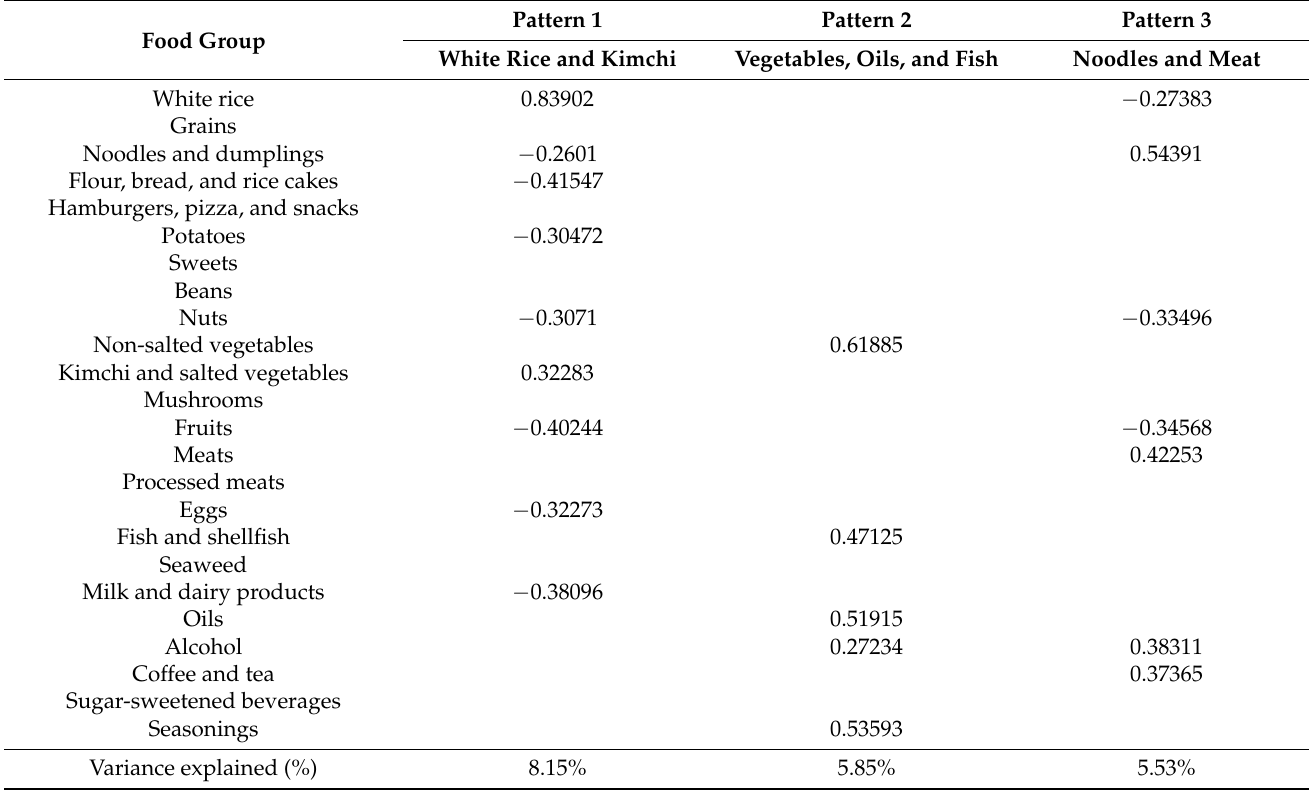
Table 2. Factor loading matrix for the three dietary patterns of older Korean